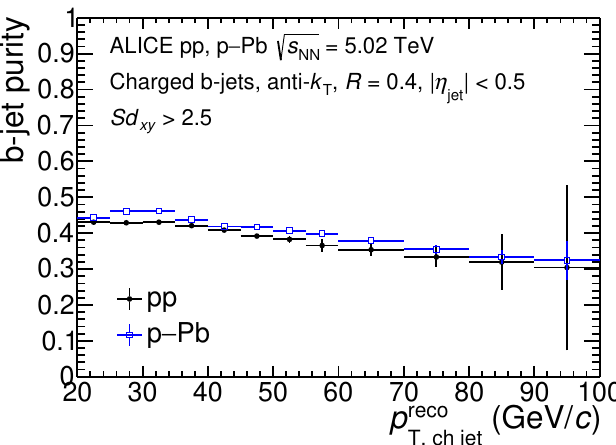
Figure 8. The b-jet purity as obtained from the IP method in pp and p-Pb